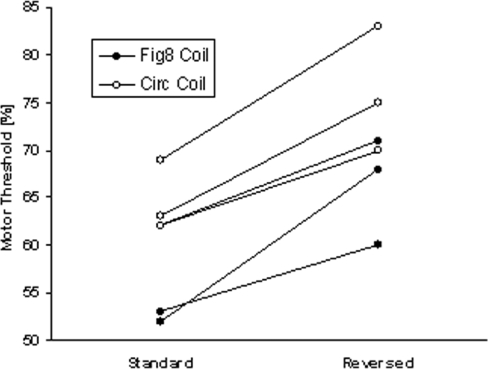
Motor Physiological Measurements.Subject motor thresholds are plotted for Standard and Reversed TMS through the Fig8 or Circ coil. Sham stimulation did not elicit muscle potentials even at maximum settings, thus threshold is beyond 100% stimulator output and not plotted.